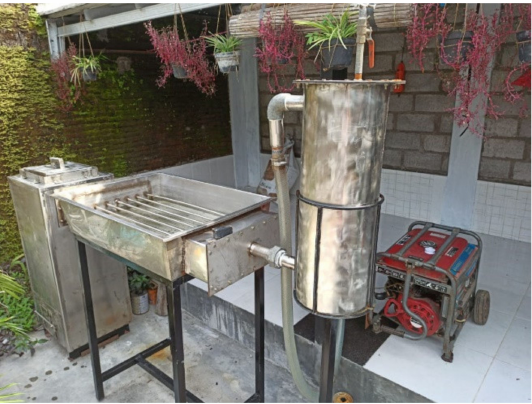
Figure 3. The experiment setup of biomass power plant with the generator set used in the testing process is the Yamakoyo GFH 4500.